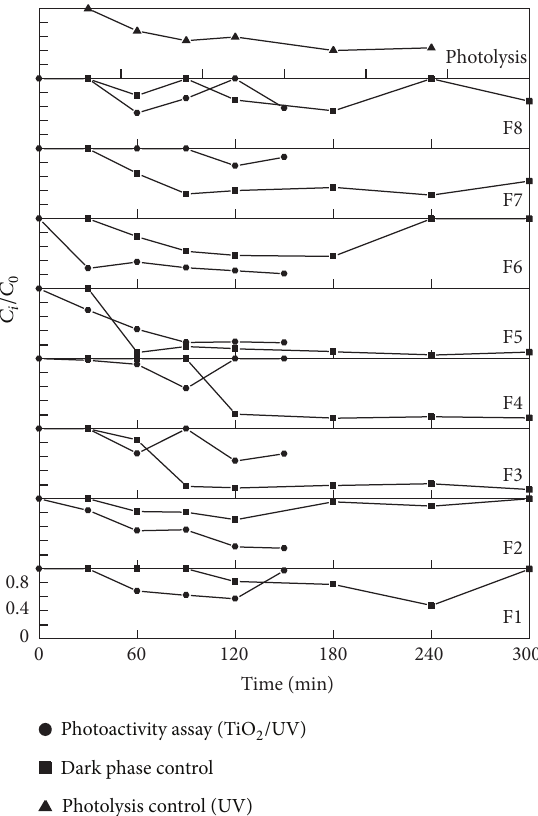
Figure 8: Total endosulfan concentration during assays. Photoac- = 0.0135 ± 0.006 , 𝐶 = tivity assay (mgL −1 ) 𝐶 0/ 0/ F 1, F 3, F 4, F 7, F 8 F 2, F 5, F 6 0.058±0.006 . Dark phase control (mgL −1 ) 𝐶 = 0.2285±0.006 , 0/ F 3, F 4 = 0.056 ± 0.019 𝐶 0/ F 1, F 2, F 5, F 6, F 7, F 8